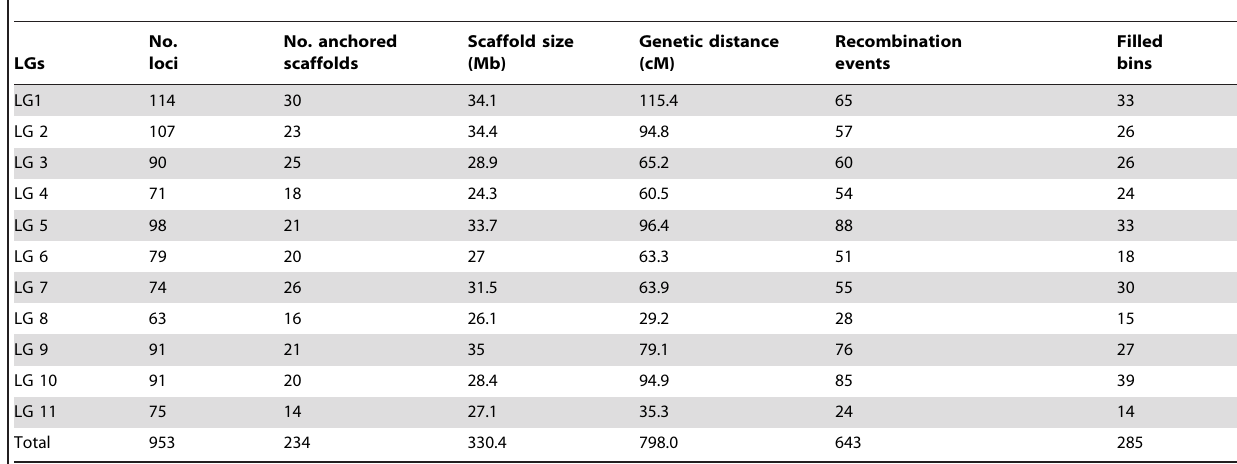
Table 1. Summary of the watermelon genetic map generated from line 97103 6 PI 296341-FR recombinant inbred lines.